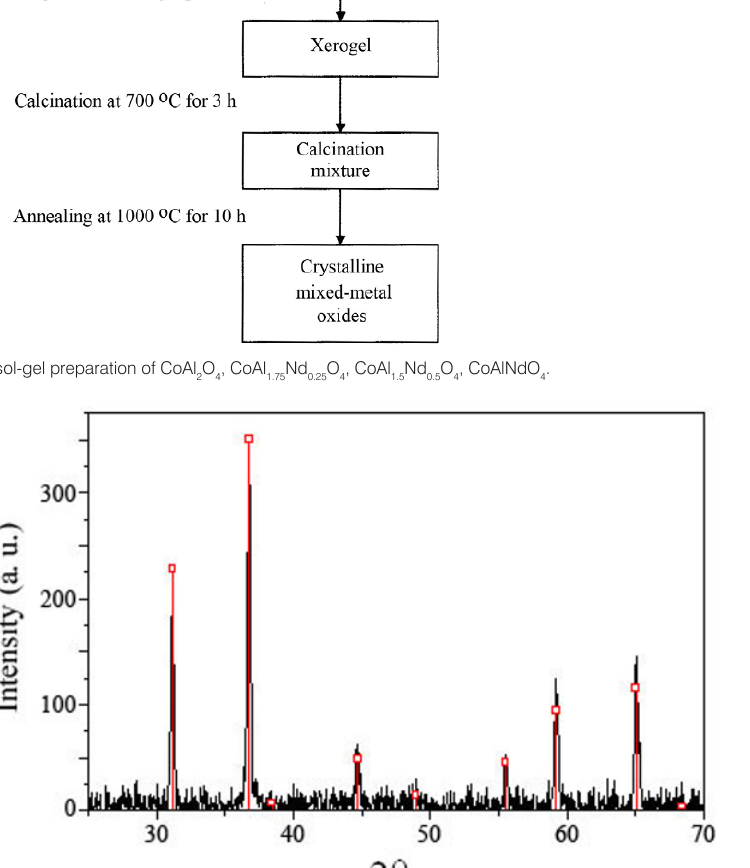
O ceramics synthesized using sol-gel method at 1000°C. Annealing time was 10 h. - reference 2 4